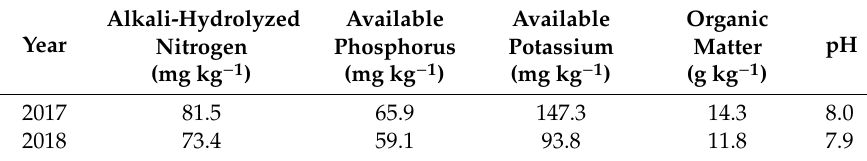
Table 2. Soil nutrient contents in the experimental